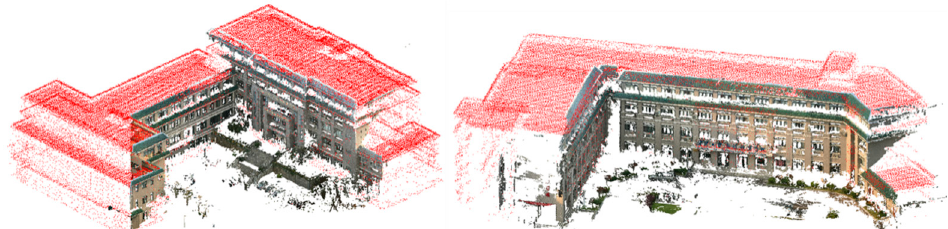
Figure 11. Fusion results of the proposed method tested on crowdsourcing images. Red points are